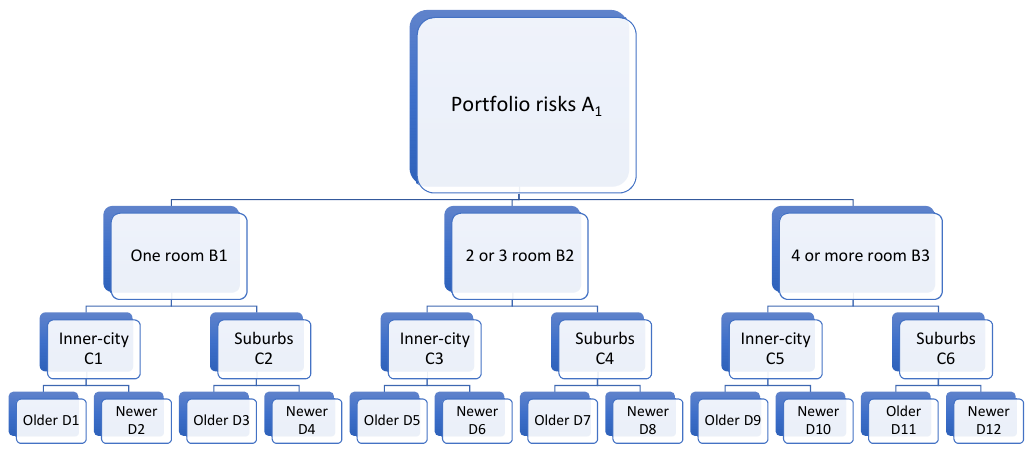
Figure 5. The structure of AHP for different housing segments in